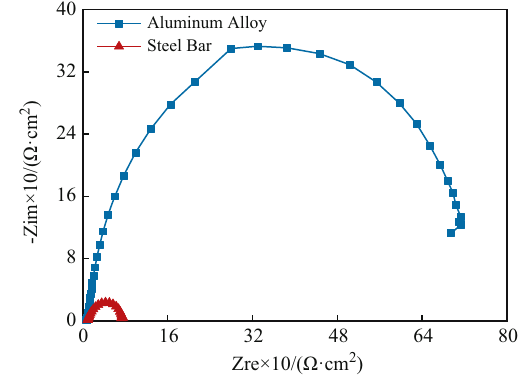
Figure 9: AC impedance spectroscopy of aluminium alloy and steel bar in the chloride